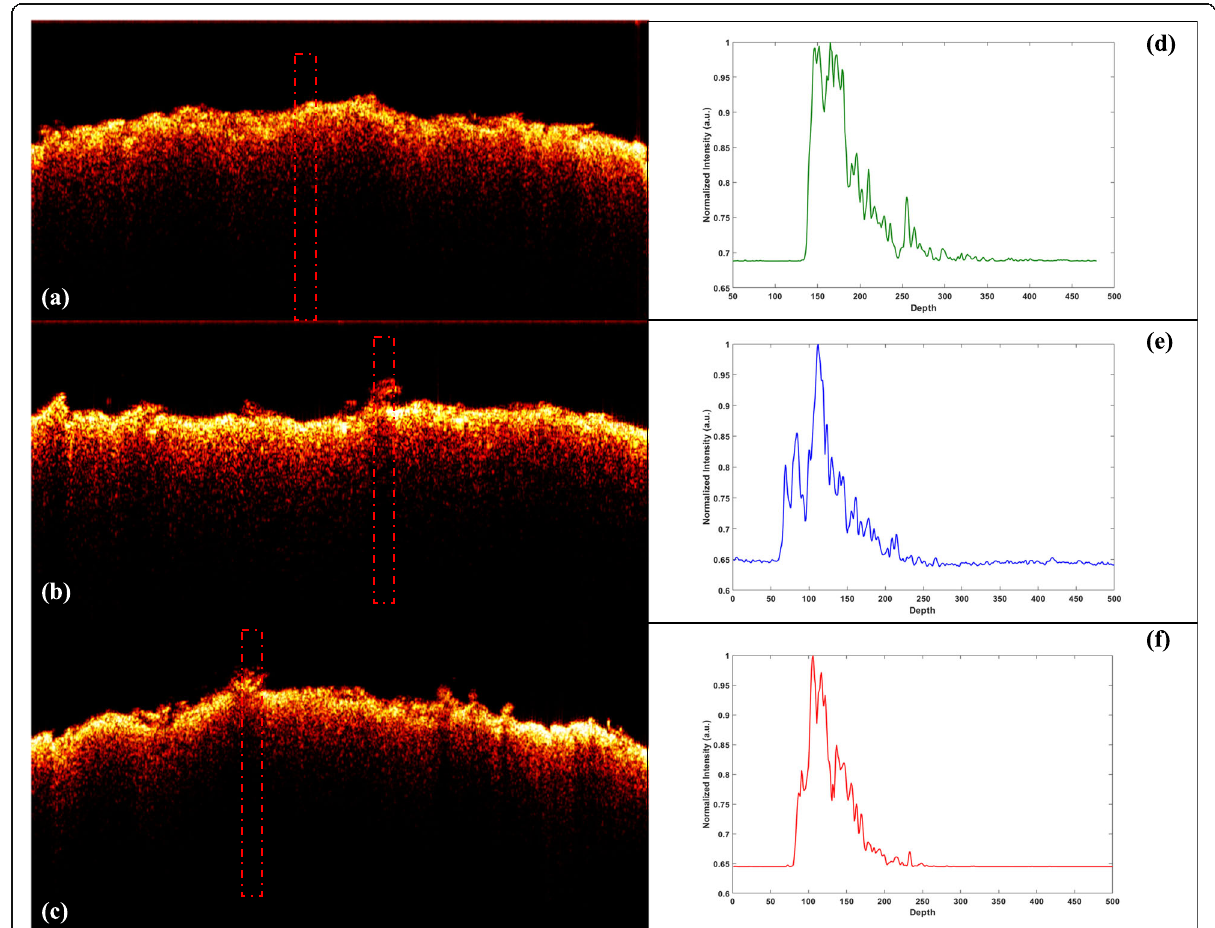
Fig. 17 Acquired OCT B-scans of different treatment of silk cocoon sheet with their corresponding A-line. OCT B-scan of only buffer treated (control) silk sheet ( a ); B-scan of silk cocoon sheet treated with cocoonase ( b ); B-scan of silk cocoon sheet treated with Na 2 CO 3 chemical ( c ). Image size 6 mm (width) × 0.9 mm (height). Red dotted rectangular boxes show the “ ROI ” region and presented in middle panel. d , e , f Averaged A-scans of “ ROIs ” for control, treatment with cocoonase enzyme, and with Na 2 CO 3 chemical,